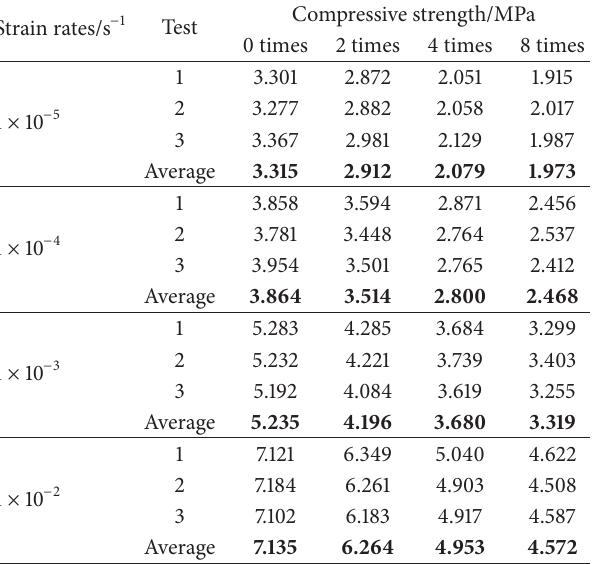
Figure 2: The schematic of universal testing machine in the loading direction.